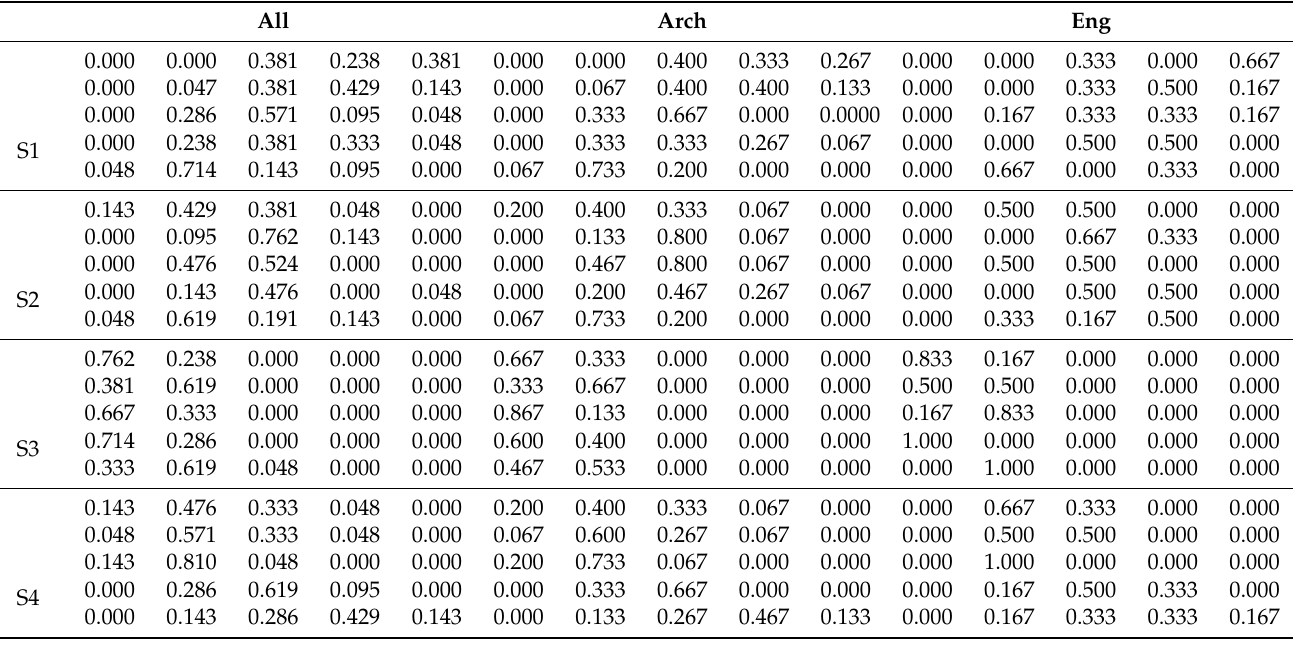
Table A1. The fuzzy matrices of criteria for the six